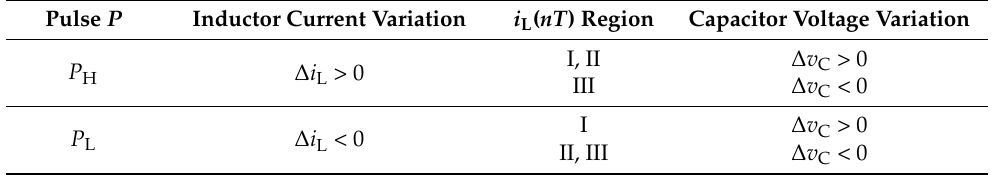
Table 1. Influence of i L ( nT ) on input voltage of